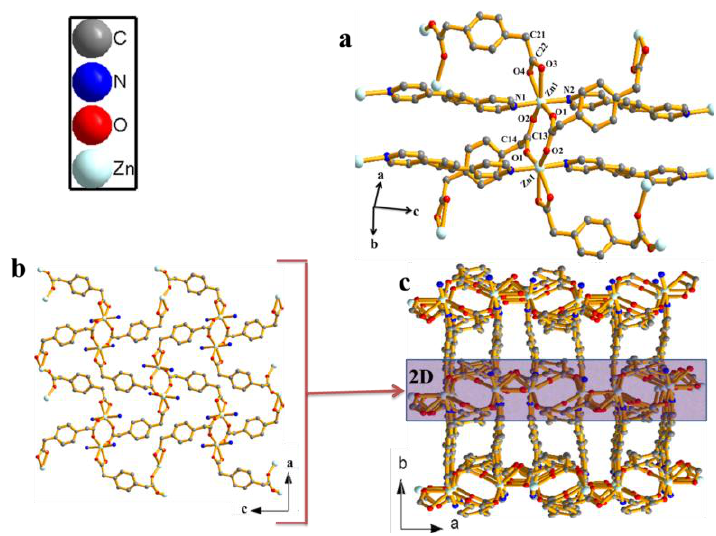
Figure 1. ( a ) Zn(II) dimeric unit of compound 1 . ( b ) 2D sheets of compound 1 observed along the b-crystallographic axis). ( c ) 3D nonporous networks of 1 assembled by connecting 2D layers (hydrogen are omitted for clarity).